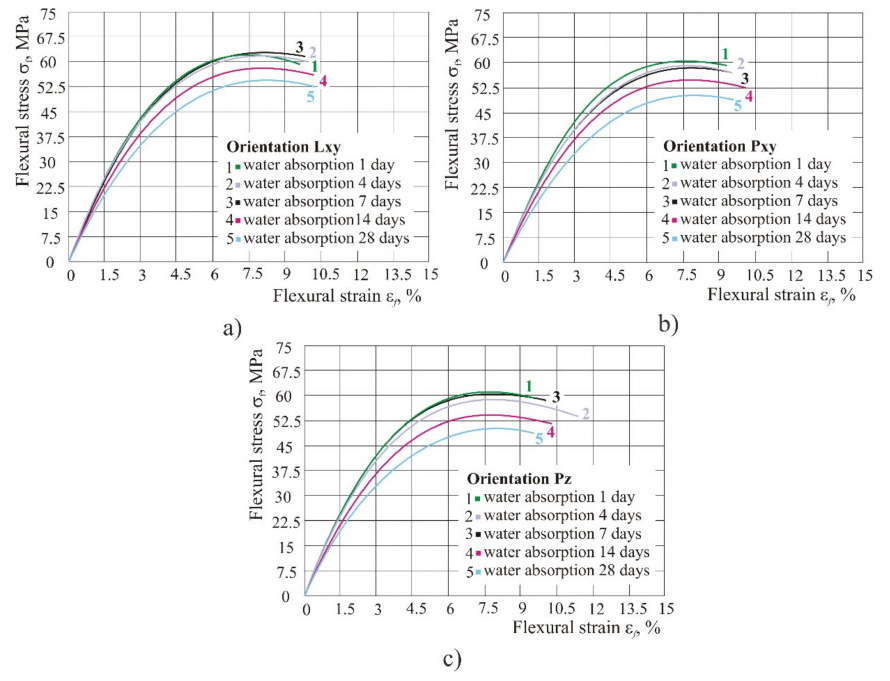
Figure 12. Diagram of flexural stress–strain in the case of water absorption: ( a ) orientation Lxy, ( b ) orientation Pxy, ( c ) orientation